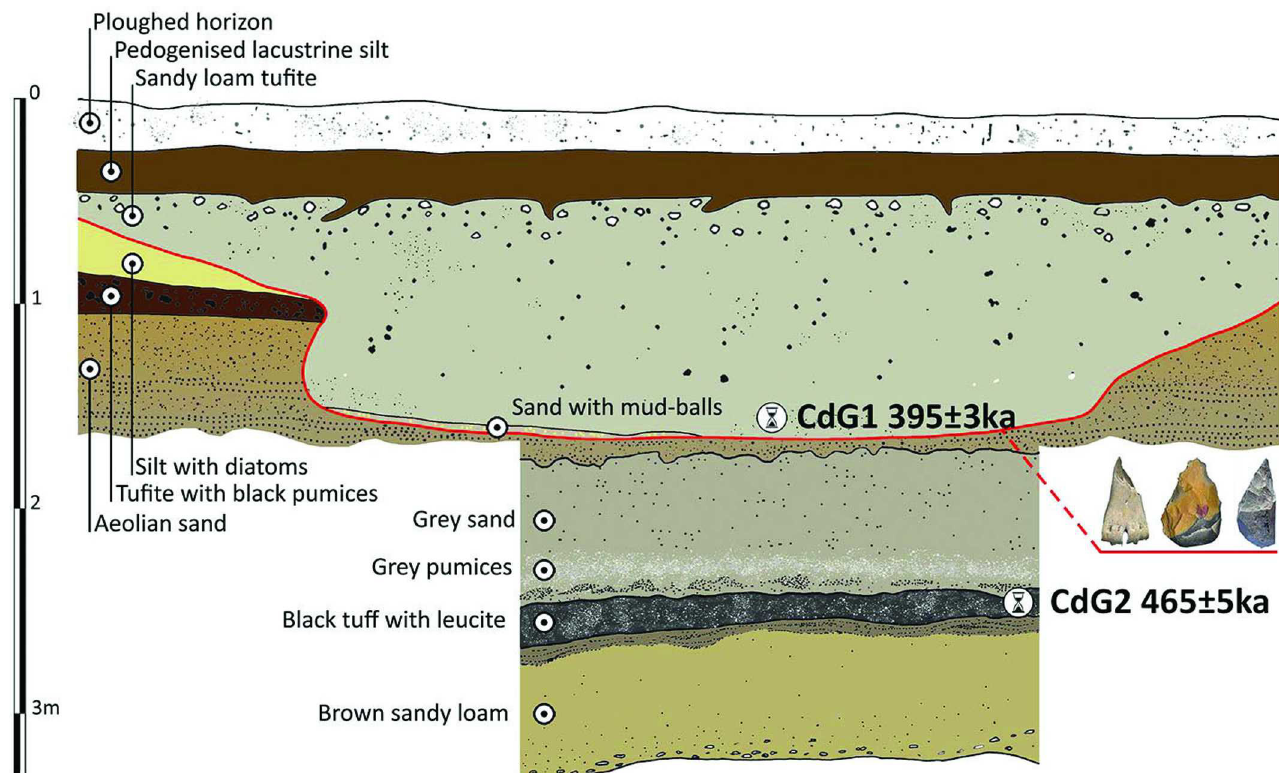
Fig 6. Excavation profile with location of the two dated samples CdG1 and CdG2. The red line indicates the paleosurface. Drawing by G. Boschian.